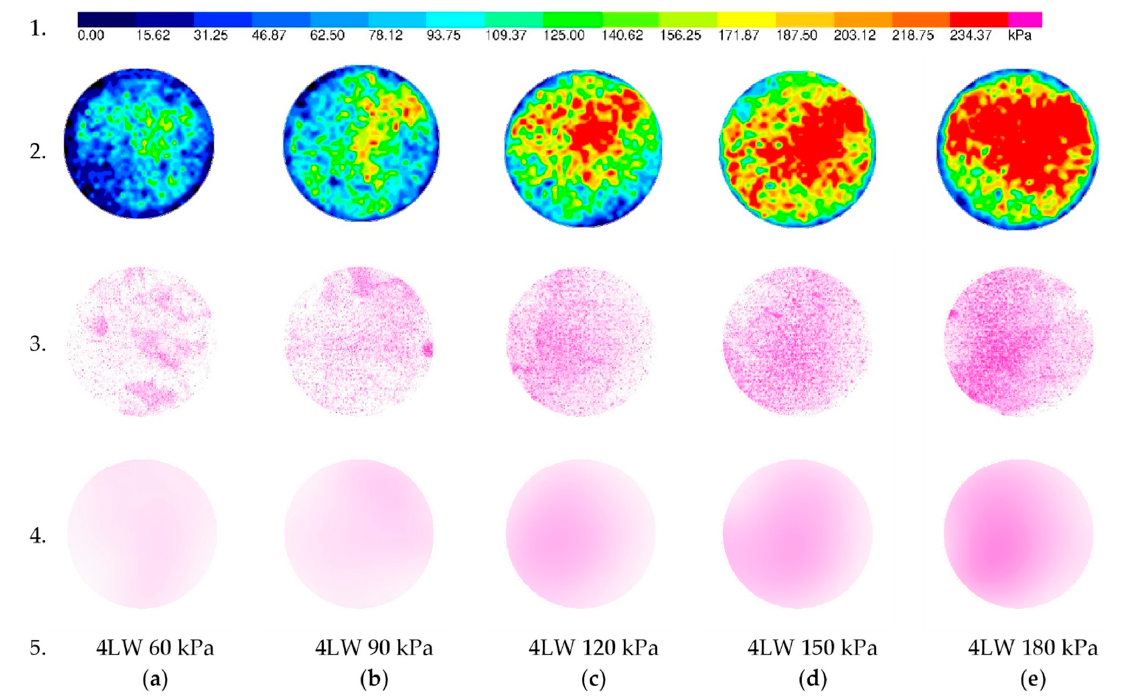
Figure 11. Comparison of contact stresses obtained from tactile and color film sensor 4 LW due to different applied stresses. Row 1. Pressure Legend, Row 2. Pressure from tactile sensor results, Row 3. Raw outcomes from color film sensors; Row 4. Average stress on the surface obtained from color film sensors; Row 5. Type of color film sensor and applied stress; ( a ) 60 kPa; ( b ) 90 kPa; ( c ) 120 kPa; ( d ) 150 kPa; ( e ) 180 kPa.